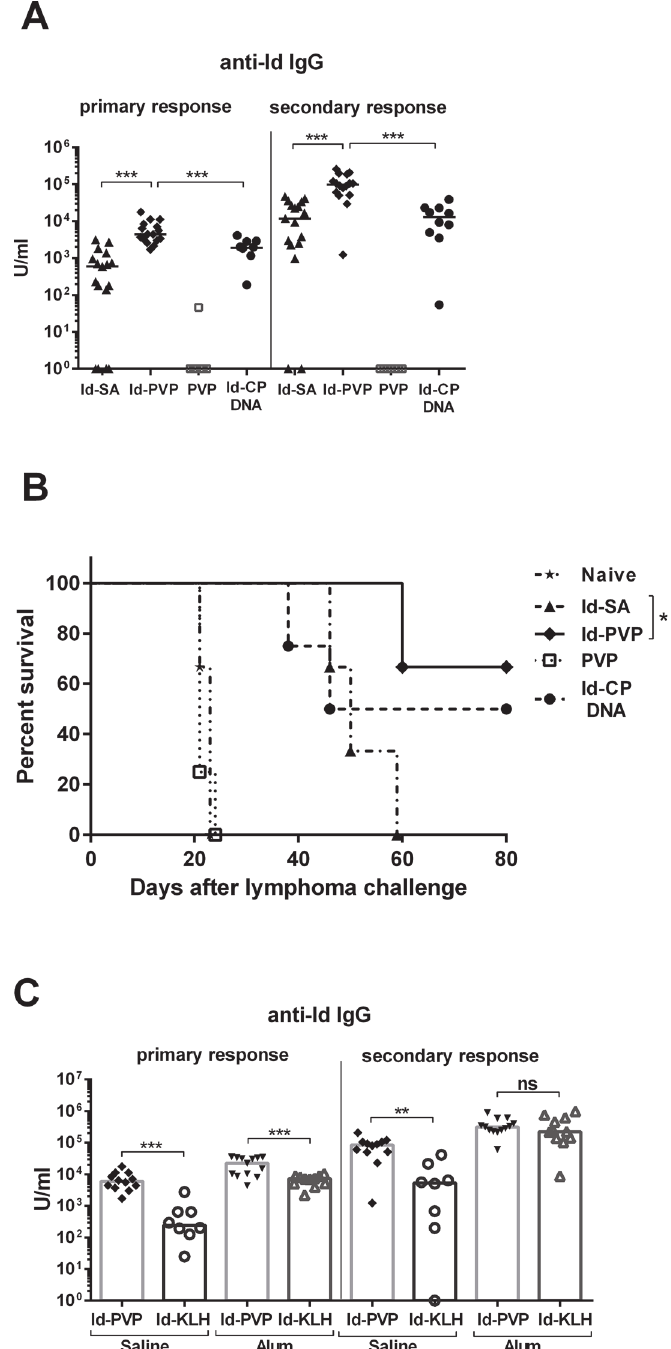
Fig 1. Induction of protective anti-Id antibody by Id conjugate vaccines. (A) and (B) . Mice were vaccinated with Id-SA, Id-PVP, PVP alone or Id-CP DNA at day 0 (priming) and again at day 21 (boosting). (A) . Total anti-Id IgG antibody was measured three weeks after priming (primary response) and two weeks after boosting (secondary response). U/ml represents antibody levels compared to an internal standard. Each symbol represents an individual mouse, with horizontal lines representing medians. The data has been combined from two representative, independent experiments, in which all groups were included. Three stars indicates significance of p < 0.001, using the Mann-Whitney statistical test. (B) . Protection from lymphoma challenge. Two weeks after boosting mice were challenged i.v. with 5x10 4 BCL1 lymphoma cells. Mice were culled upon reaching a predetermined level of splenomegaly. One star indicates significance of p =